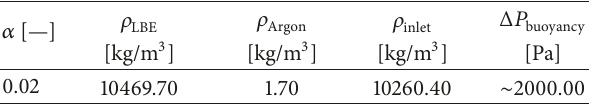
Figure 21: Comparison between pressure drops. Table 1: Pressure difference due to the buoyancy